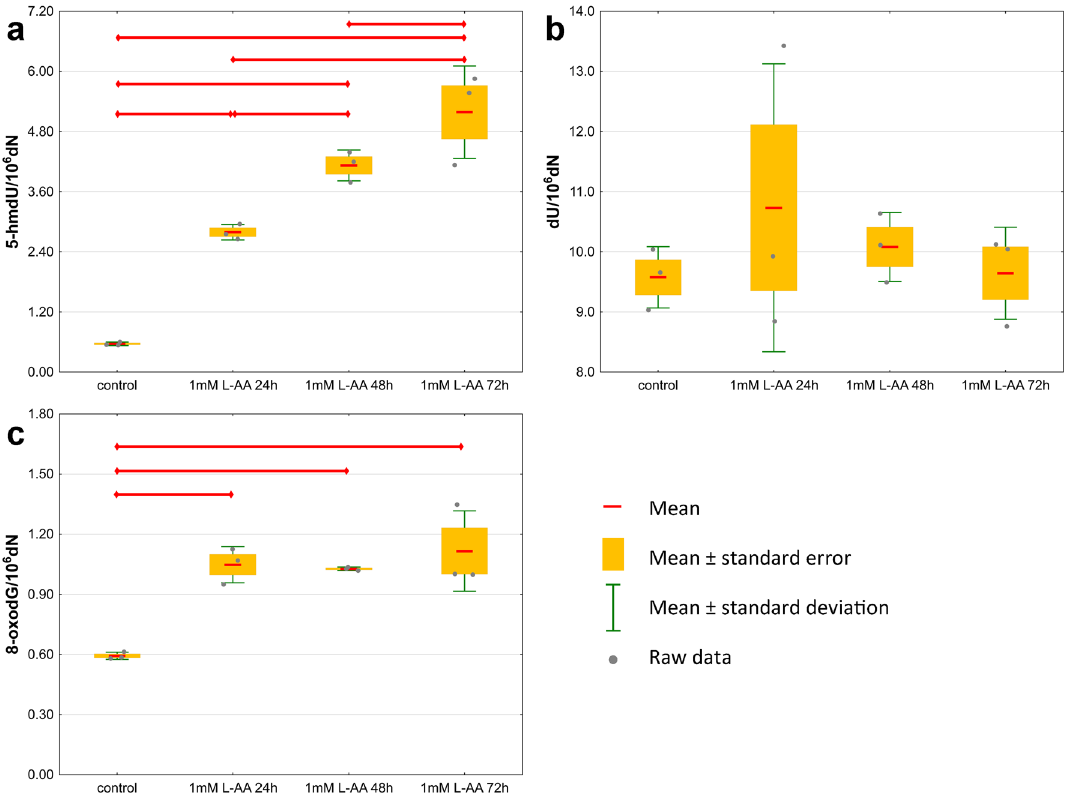
Figure 5. The levels of the DNA modifications in S2 cells cultured with the addition of 1 mM L-AA for 24 h, 48 h and 72 h ( a ) 5-(hydroxymethyl)-2 ′ -deoxyuridine (5-hmdU), ( b ) 2 ′ -deoxyuridine (dU), ( c ) 8-oxo-7,8- dihydro-2 ′ -deoxyguanosine (8-oxodG). The results are presented as the mean, mean ± standard error and mean ± standard deviation ( p <